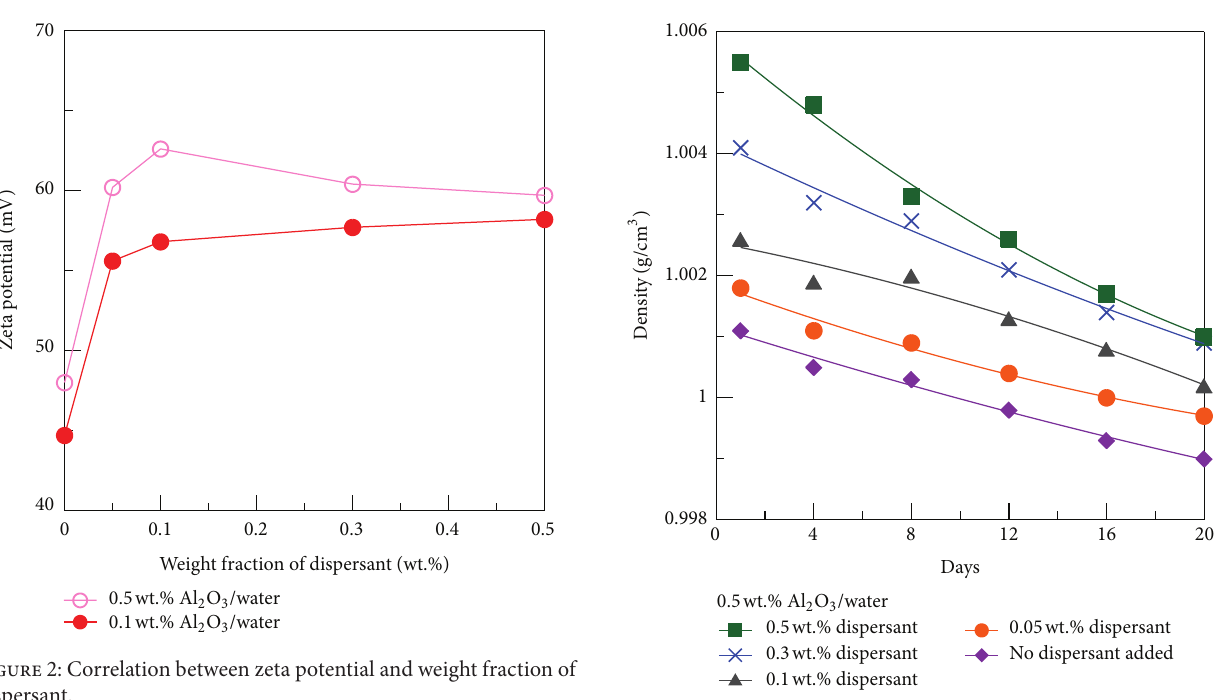
Figure 3: Correlation between weight concentration and precipita- tion behavior (0.5 wt.% Al 2 O 3 /water).